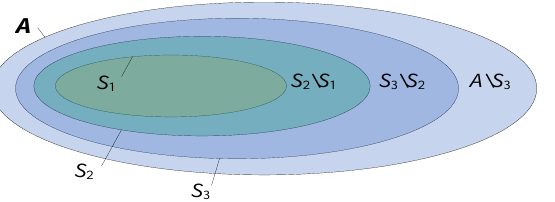
Figure 2. Analysis of the damage extent for failure mode A , different subsets of damaged compo- nents.